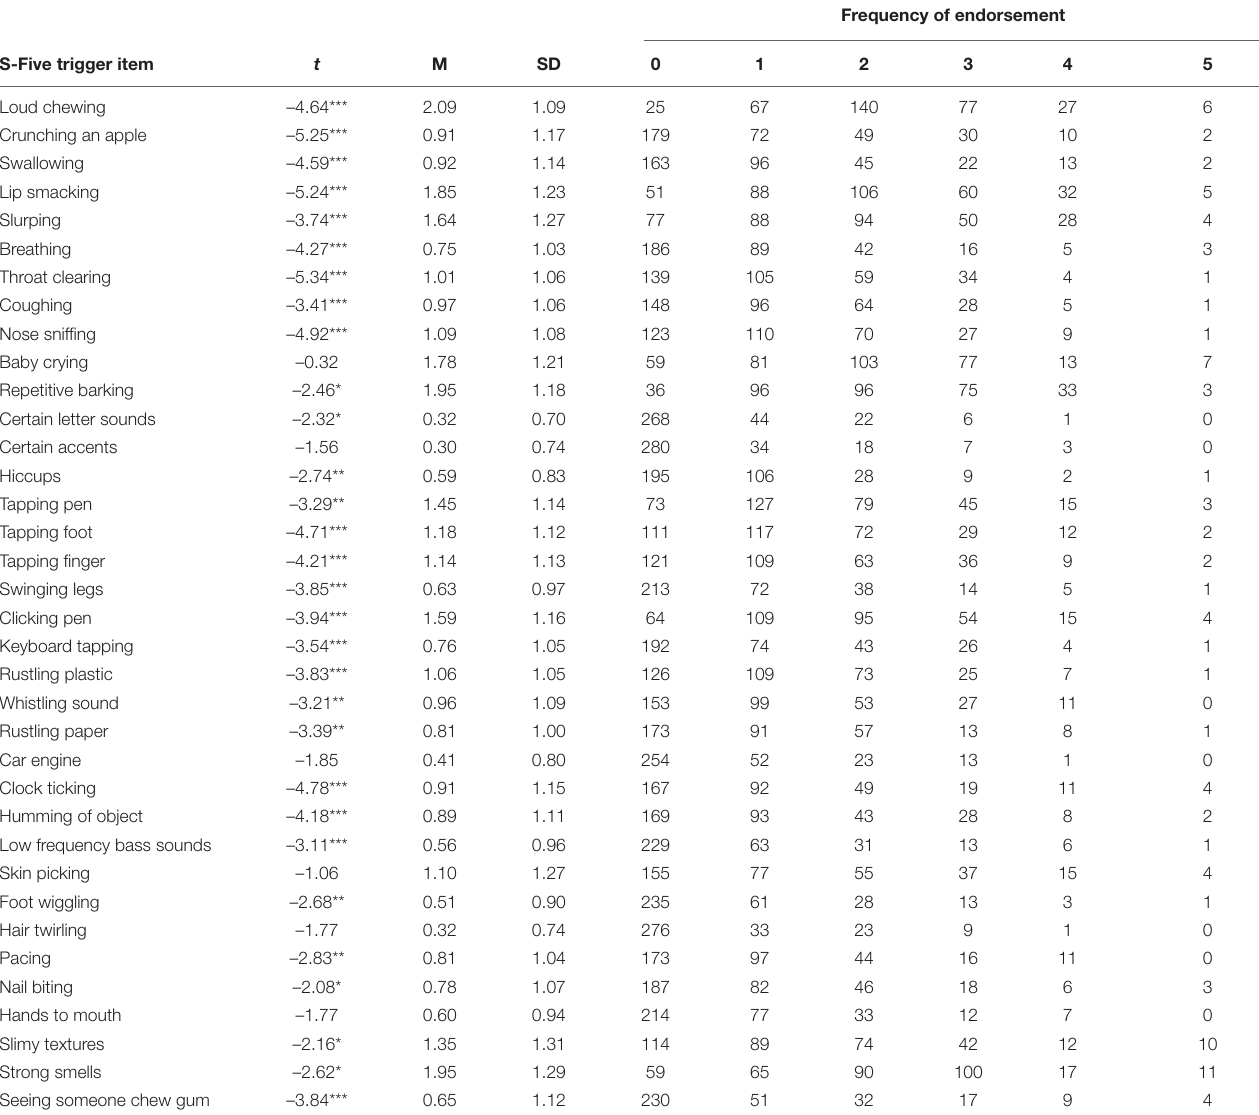
TABLE 3 | Trigger items endorsed across all participants on the trigger section of the